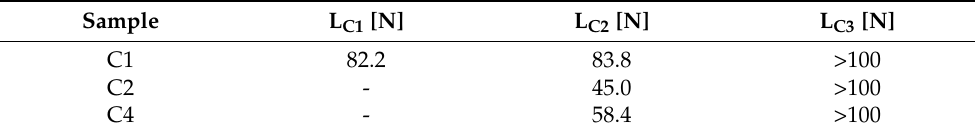
Figure 2. Scratch paths of the C-coatings. In the picture, just final parts of the paths are compared; the paths are incommensurable in this picture. Table 3. Summary of the scratch adhesion values evaluated for the